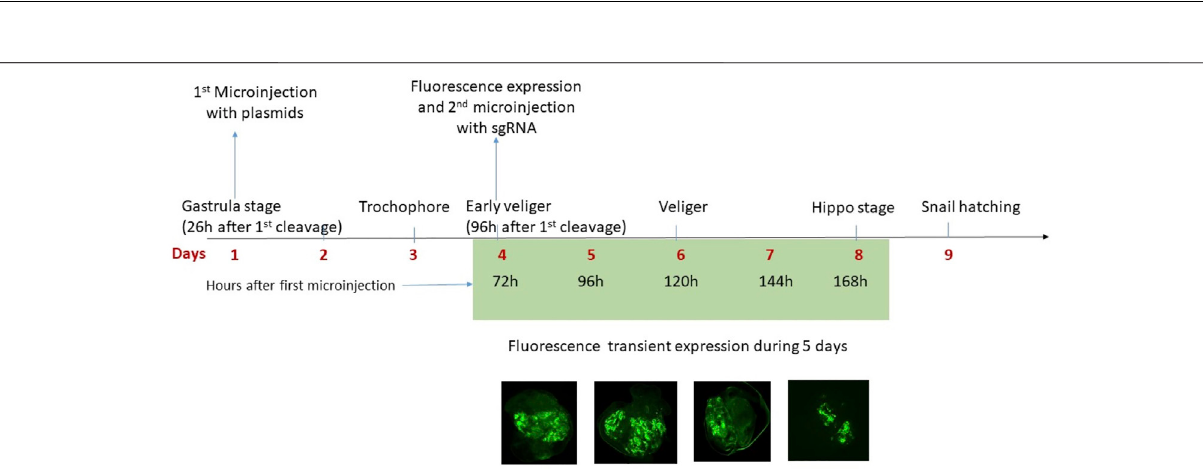
Frontiers in Cell and Developmental Biology |